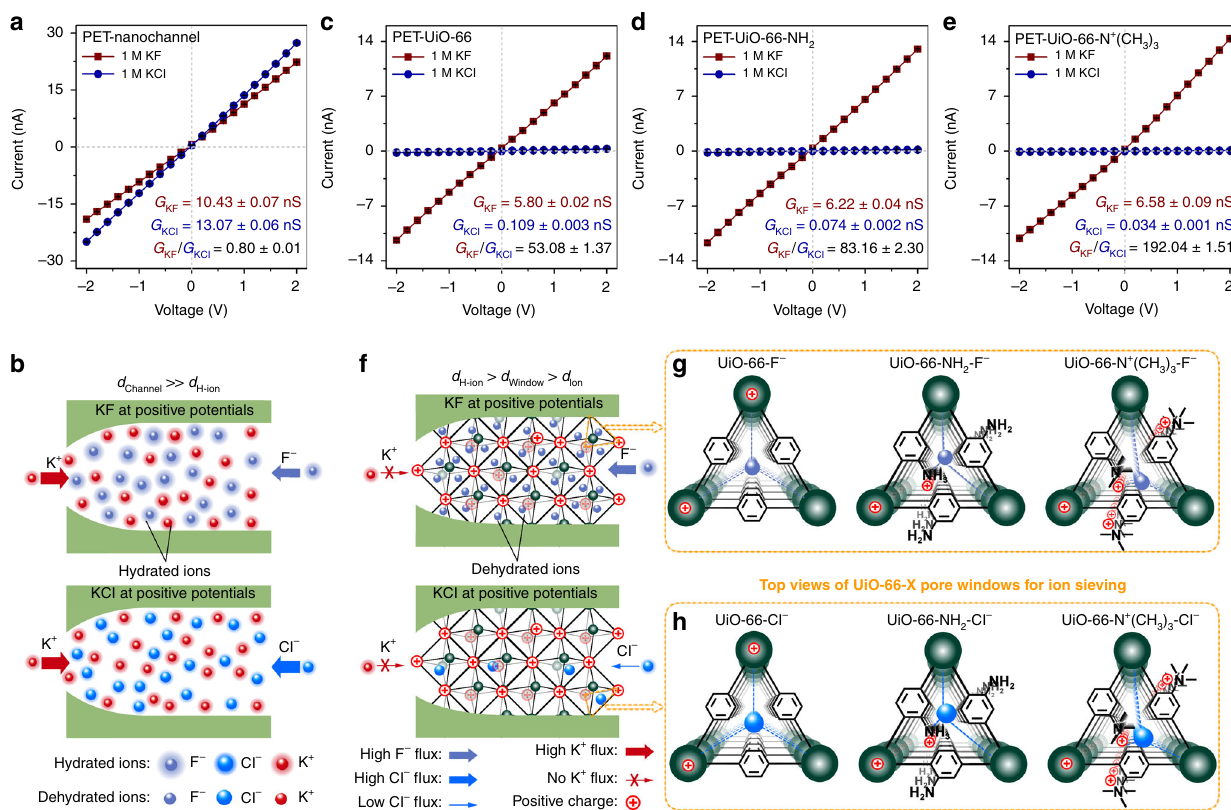
Fig. 3 Ionic transport properties of PET nanochannels and sub-1-nanometer MOF channels. a Symmetric I ‒ V curves of a bullet-shaped PET-nanochannel observed in 1.0 M KF and KCl solutions, respectively. b Schematics of hydrated ions transport in a PET-nanochannel. Because d Channel ≫ d H-ion , ions are hydrated in the PET-nanochannel. The diameter of hydrated F − is larger than that of hydrated Cl − , so hydrated F − ions conduct slower than hydrated Cl − ions in the PET-nanochannel. c – e I – V curves of PET-UiO-66-X nanochannels measured in 1.0 M KF and KCl solutions, respectively. Compared with UiO-66 and UiO-66-NH 2 channels, UiO-66-N + (CH 3 ) 3 channels exhibit the highest F − conductance and selectivity. Error bars represent the standard deviation of three measurements of a sample. f Schematic illustrations of dehydrated ions passing through sub-1-nanometer PET-UiO-66-X nanochannels. Ions are dehydrated in MOF channels because d H-ion > d Window > d Ion . The angstrom-sized MOF pore windows with speci fi c F − binding zirconium sites and functional NH 2 and N + (CH 3 ) 3 groups serve as F − selectivity fi lter for ion sieving, so dehydrated F − ions conduct faster than Cl − in PET-UiO-66-X nanochannels. g , h Top view of UiO-66-X pore windows. UiO-66-N + (CH 3 ) 3 channels have the smallest window size and strongest F − speci fi c interactions due to the N + (CH 3 ) 3 groups compared with UiO-66 and UiO-66-NH 2 PET-nanochannel before and after UiO-66-X growth were mea- sured in 1.0 M KF and KCl aqueous solutions (see Supplementary Fig. 4a, b for the testing apparatus). For pristine bullet-shaped